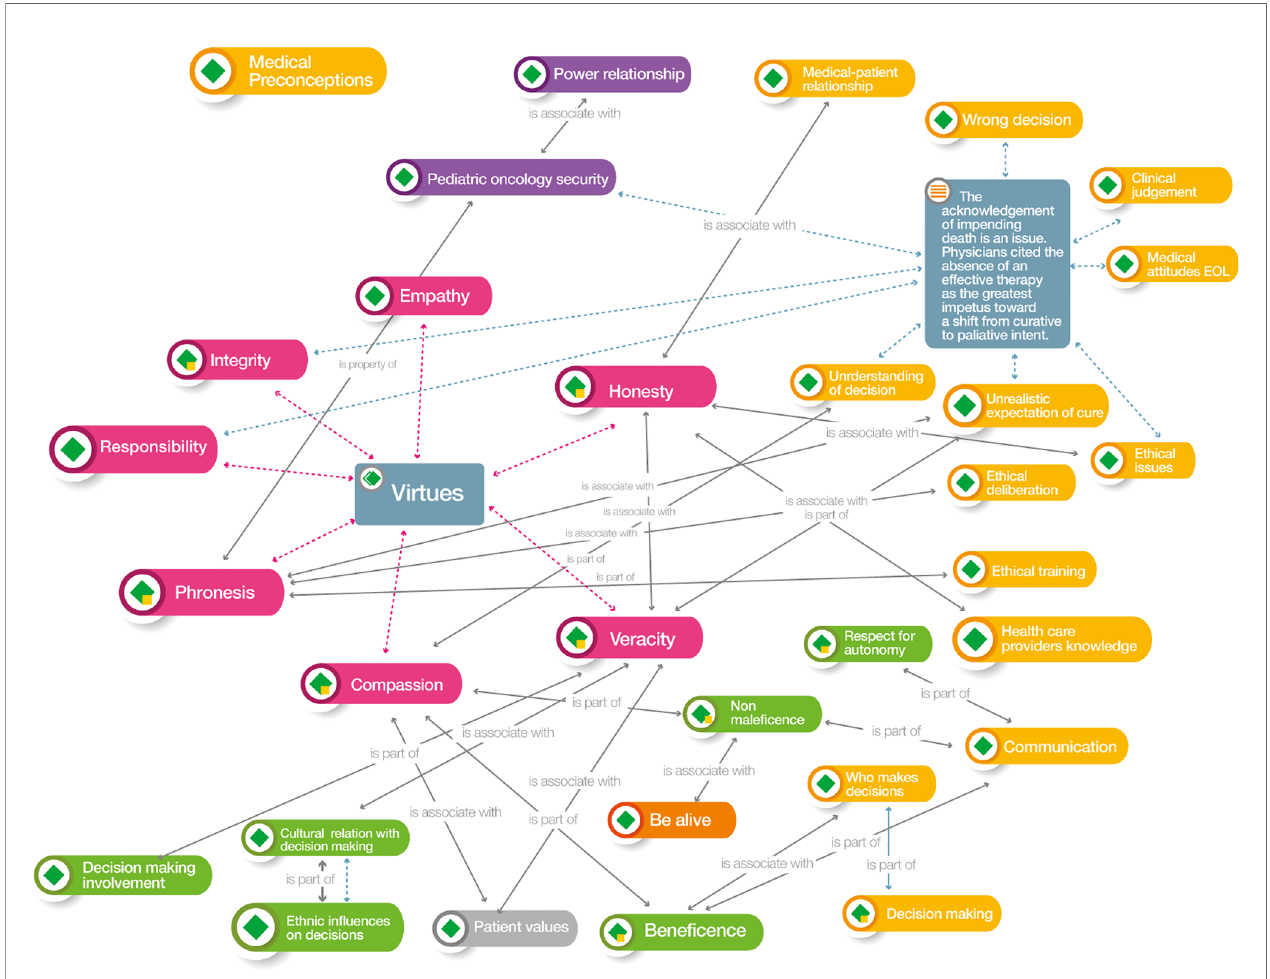
FIGURE 3 | Atlas.ti v.9 ® Axiological horizon network. Color codes Groups: Red: Medical virtues; Yellow: Medical factors that in fl uence decisions; Dark green: Biomedical ethics principles; Green: Parents-patients ’ factors for decision-making; Grey: Patients factors for decision-making; Violet: Medical barriers for decision- making; Orange. Clinical determinants at end-of-life for